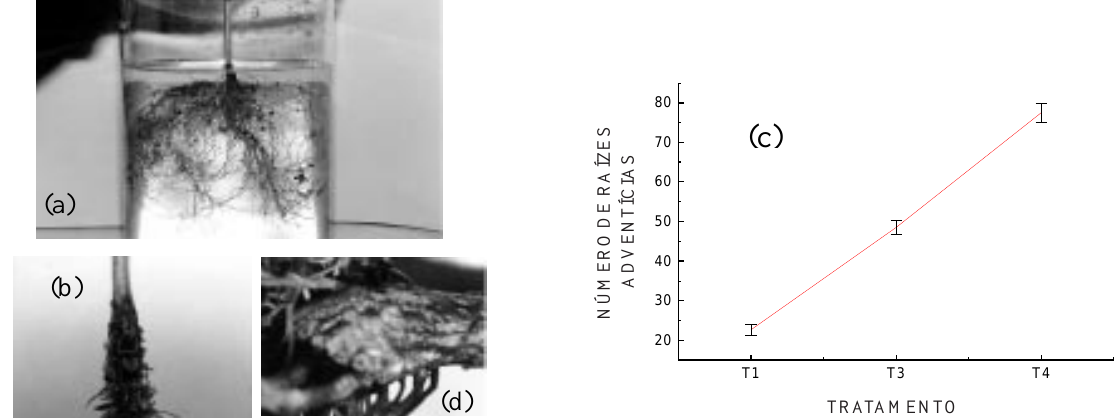
Figura 4. (a e b) Emissão de raízes adventícias; (c) número de raízes, por tratamento; (d) tecido de penetração de O na base do caule do 2